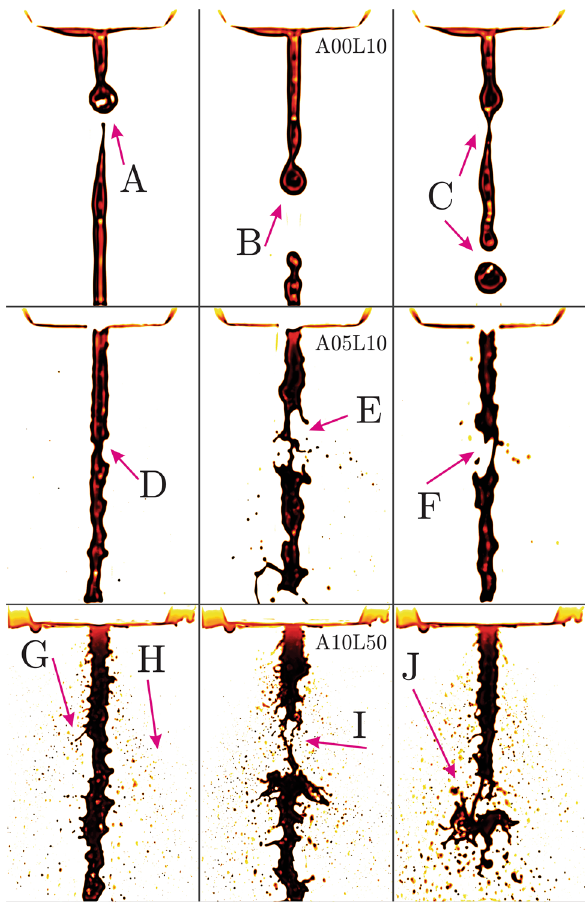
Figure 1. Bio-oil preheated to T = 24 ( ◦ C) ( T 24 cases) with liquid q f = 4.5, 22.5 (kg/h) ( L 10 and L 50 cases at 10 and 50 (lb/h)) and air q a = 0, 5, 10 (l/min) ( A 00, A 05 and A 10 cases) injection rates. (FOV: 9.25 d a × 14.27 d a